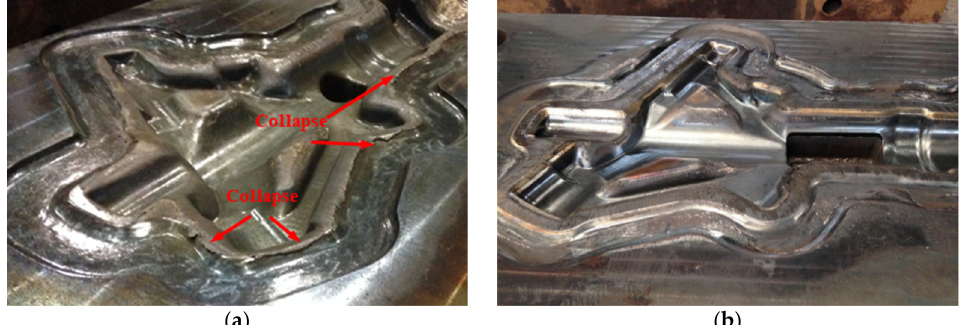
Figure 14. Appearance of traditional homogeneous die and repaired die with gradient structure: ( a ) Appearance of traditional homogeneous die after forging twice; ( b ) Appearance of gradient structure die after forging 20 times.